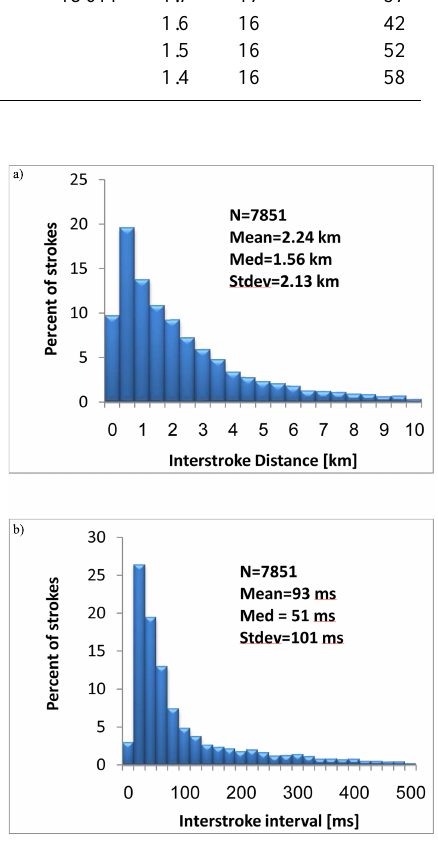
Fig. 2. (a) Distribution of inter-stroke distances in km. (b) Distribu- tion of the inter-stroke time interval in